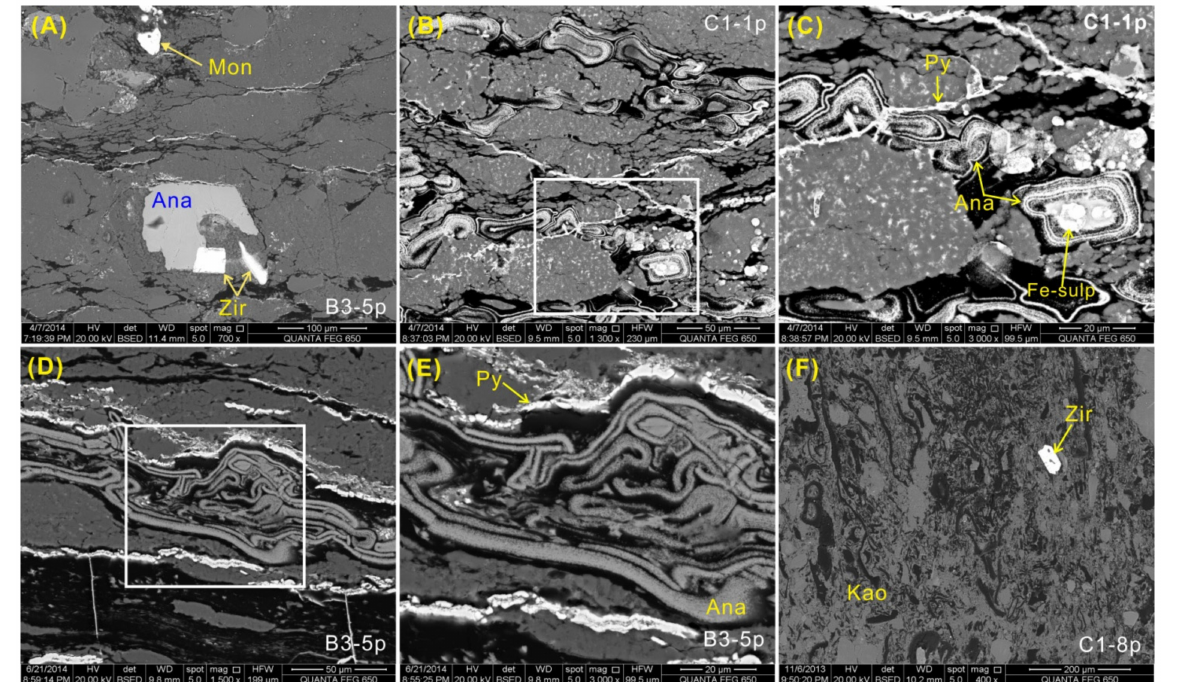
Figure 13. SEM back-scattered electron images of accessory minerals in tonsteins. ( A ) Anatase, zircon, and monazite in B3-5p. ( B ) Anatase possibly replacing glass spherules in C1-1t. ( D ) Fracture-filling anatase and pyrite in B3-5p. ( C , E ) are the enlargement of rectangles in ( B , D ). ( F ) Zircon in C1-8p. Mon: monazite. Ana: anatase. Zir: zircon. Fe-sulp: Fe-bearing sulfate mineral. Py: pyrite. Kao: